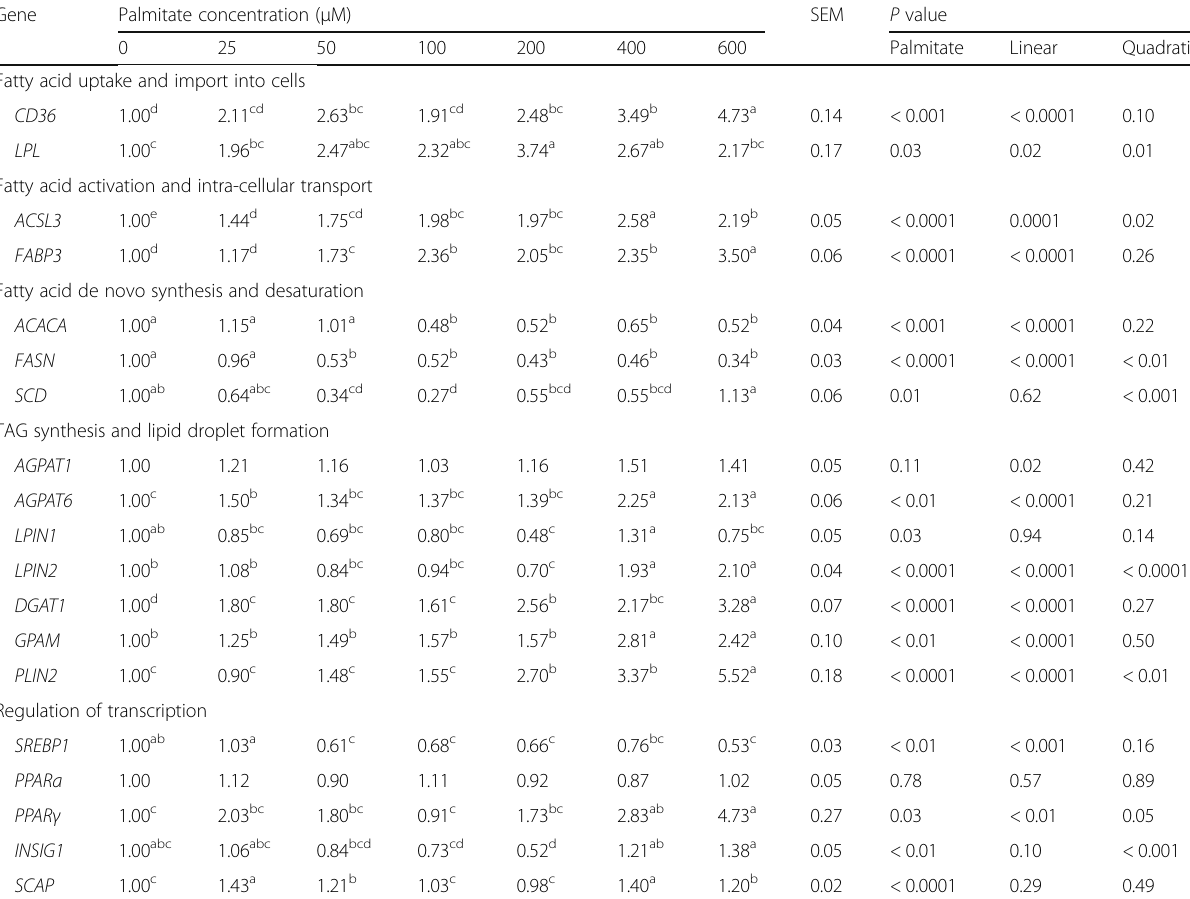
Different letters indicate statistical significance between different concentrations of palmitate treatment groups ( p